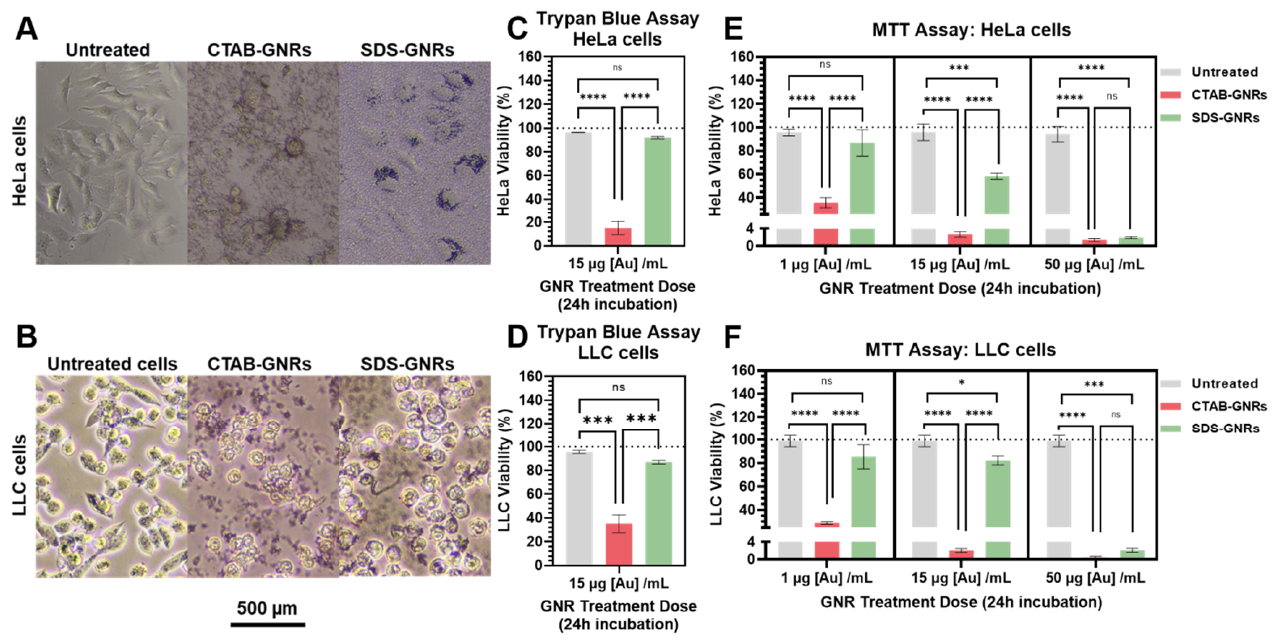
Figure 3. Effects of CTAB-GNR and SDS-GNR treatment on cell viability. Optical microscopy images of ( A ) HeLa and ( B ) LLC cells treated and incubated for 24 h with 15 μg [Au] /mL CTAB-GNRs and SDS-GNRs. Trypan blue assay for ( C ) HeLa and ( D ) LLC cells treated and incubated for 24 h with CTAB-GNRs and SDS-GNRs. Significant difference between groups (** * p < 0.0005, **** p < 0.0001). MTT assay for ( E ) HeLa and ( F ) LLC cells treated and incubated for 24 h with CTAB-GNRs and SDS-GNRs. Significant difference between groups (**** p < 0.0001) for all treatment doses. SDS-GNRs are significantly cytotoxic at higher doses in both cell lines. All data in the figure are reported as mean ± s.e.m in triplicate.